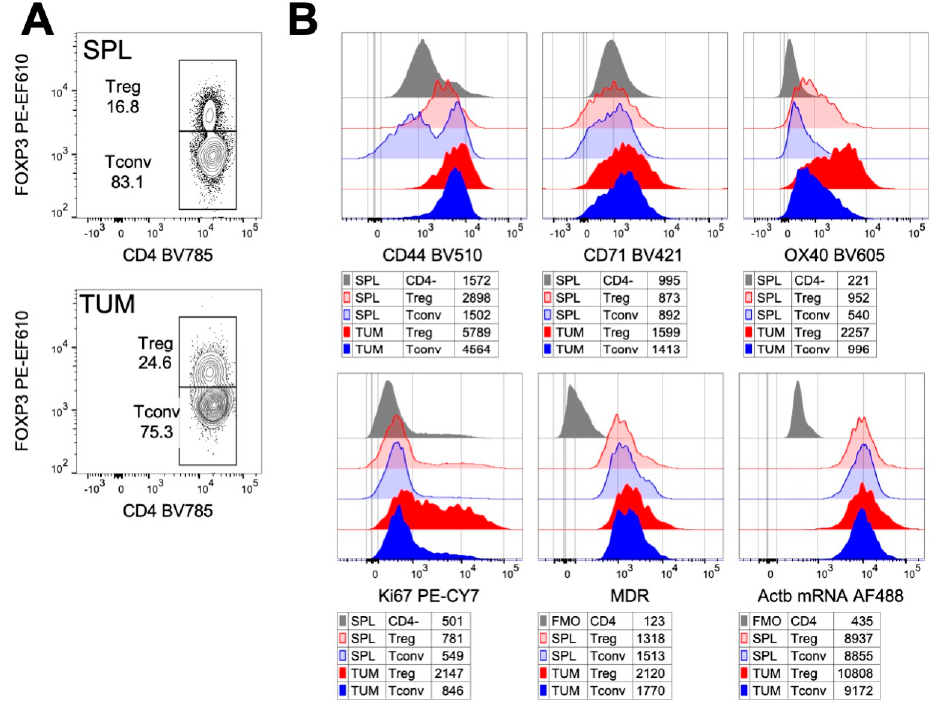
Figure 3. Detection of β -Actin mRNA in combination with surface and nuclear proteins and with mitochondrial mass in Tregs and Tconvs from splenocytes (SPL) and tumor tissue (TUM) by flow cytometry. MC38 cells (5 × 10 5 ) were subcutaneously injected into C57BL/6 mice and Prime Flow assay and flow cytometry analysis were performed on lymphocytes extracted from splenocytes and tumor tissue at 17 days post-tumor transplantation. Staining was performed according to the workflow in Figure 2. ( A ) Contour plots showing the strategy for the identification of Tregs and Tconvs in SPL and TUM, according to Foxp3 intranuclear expression. ( B ) Overlay of the histograms showing the expression of each marker in the indicated cell subset and tissue. Numbers in the legends indicate the geometric mean fluorescence intensity (gMFI). Grey histograms represent the fluorescence-minus-one (FMO) negative controls or CD4-negative cells, as control.